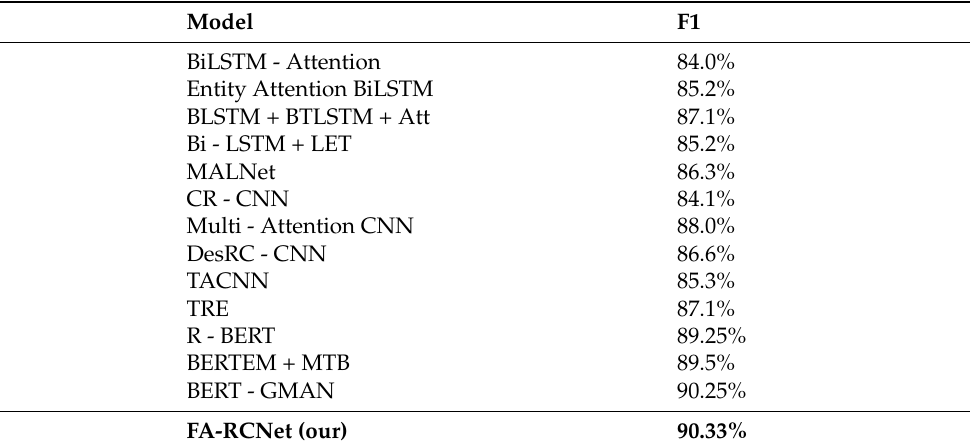
Table 6. A comparison test with other relational classification models on the SemEval-2010 Task8 dataset.